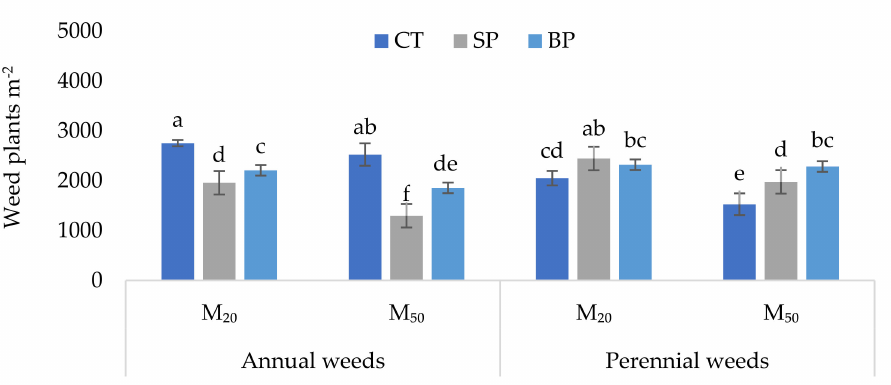
Figure 2. Density of emerged annual and perennial weeds from topsoil (0–15 cm) at 30 days after emergence from soil collected from Digram after 5 years under strip planting (SP), bed planting (BP) and conventional tillage (CT). Values are means of four replicates. The means with similar letters (a − f) do not differ significantly at p ≤ 0.05. M 20 = 20% residue, M 50 = 50% residue. Whiskers mean the standard